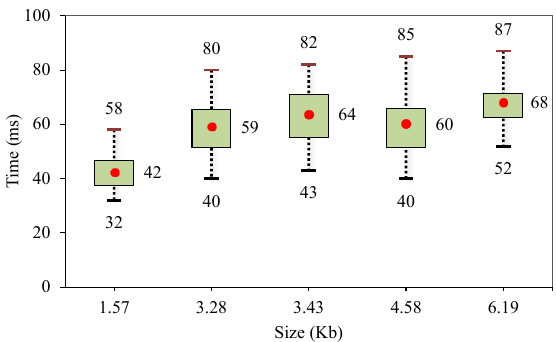
Figure 8. Total time for downloading and updating device